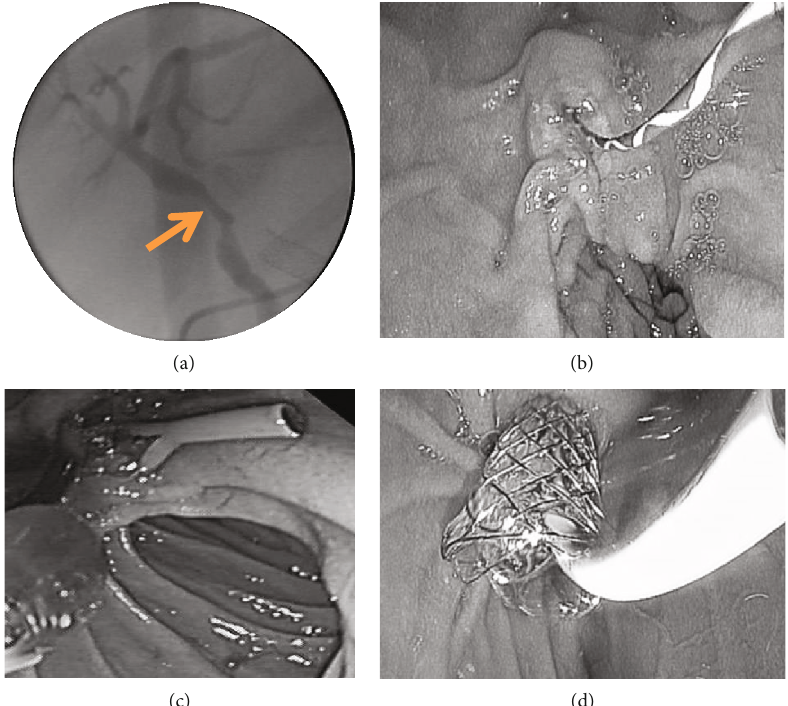
Figure 1: Surgical procedure of ERCP in the treatment of biliary strictures after liver transplantation. (a) Before ERCP, cholangiography showed biliary strictures; (b) the Boston zebra guide wire was placed into the intrahepatic bile duct; (c) the plastic stent was successfully placed with balloon dilator; (d) metal stent placed